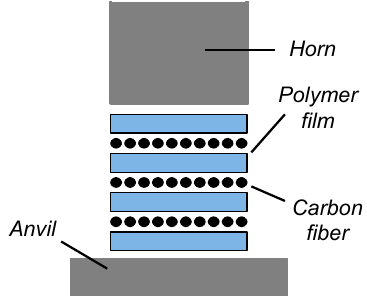
Figure 5. Schematic illustration of the ultrasonic fabrication of multi layered CFRP.